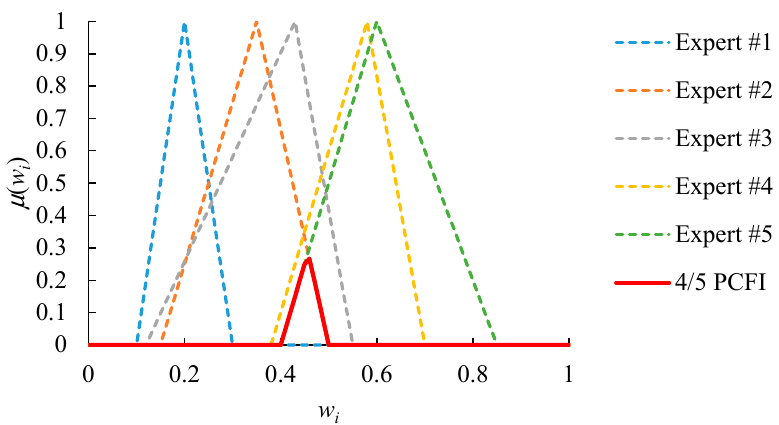
Figure 5. The partial consensus among any four experts in the previous example.